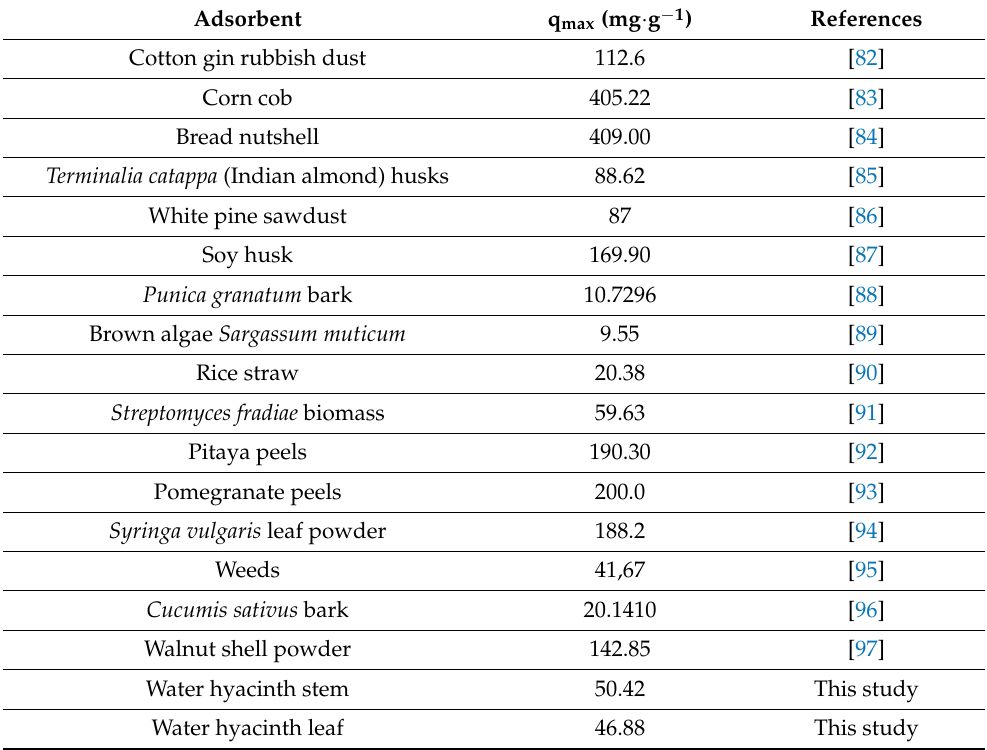
Table 4. Comparison of the maximum adsorption of methylene blue by the bioadsorbent produced from the leaf and stem of water hyacinth with various